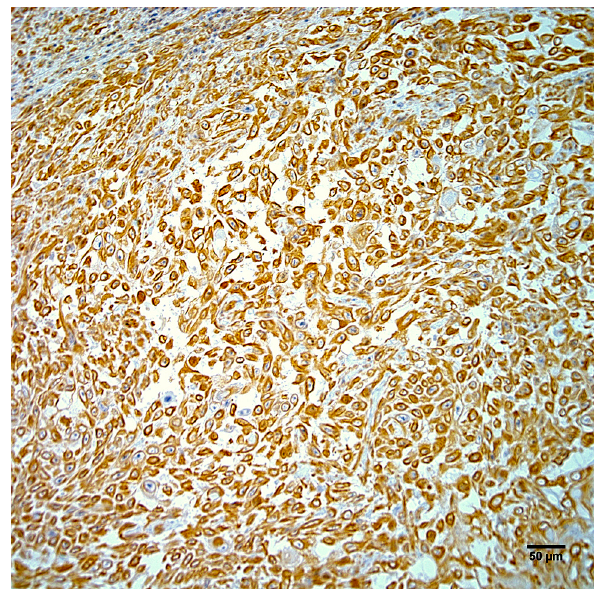
Figure 5. Neoplastic cells from the right hindlimb mass exhibit strong positive cytoplasmic immunostaining for vimentin. Hematoxylin counterstain. Scale bar 50 µm.